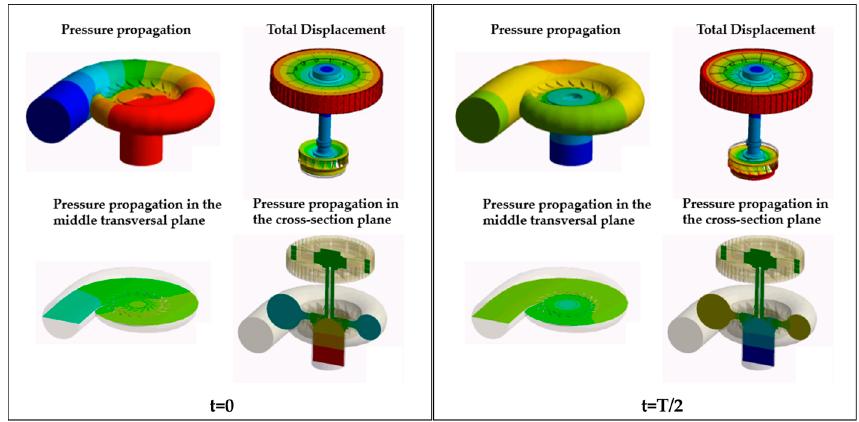
Figure 17. Pressure propagation through the entire hydraulic circuit and the forced response of the structure in a cycle. Red color maximum and blue color minimum.